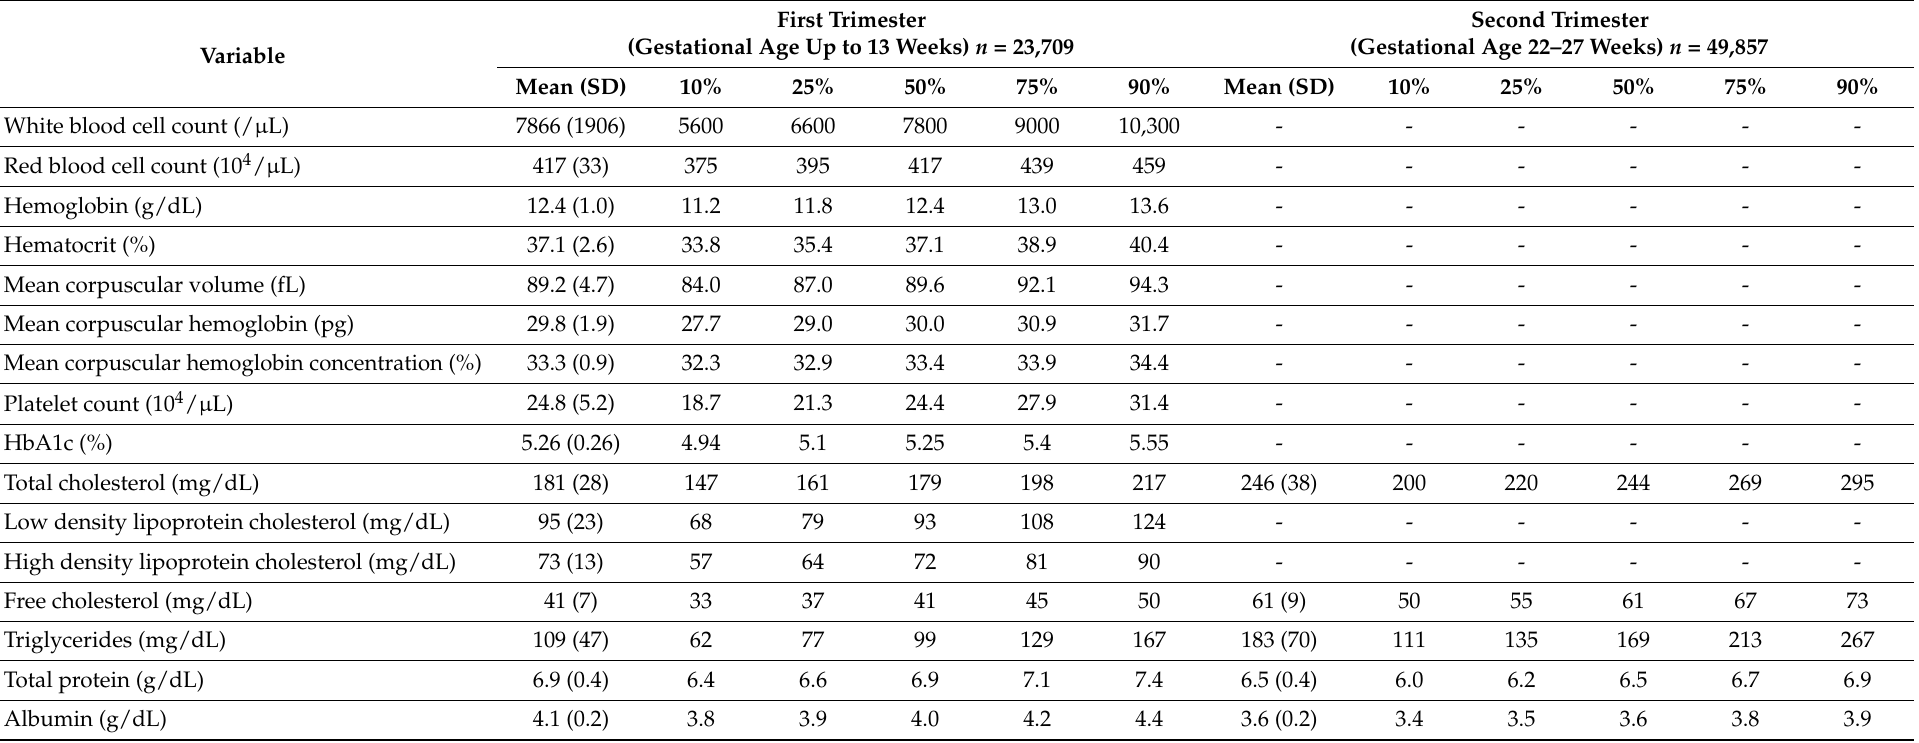
Table 2. Baseline complete blood count and chemistry panel profile of pregnant women in their first and/or second